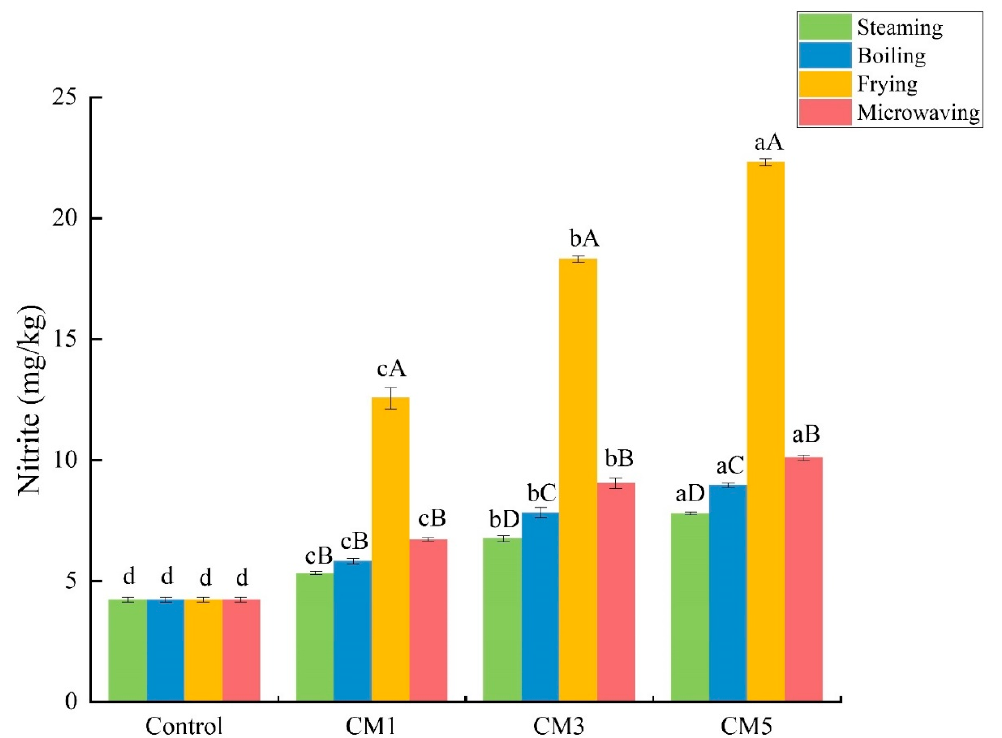
Figure 2. Comparison of nitrite residues in camel meat after different heat processing methods. Different lowercase letters indicate significant differences according to the different heating times ( p < 0.05), and different capital letters indicate significant differences according to the different heating treatments ( p < 0.05). The control group was untreated. The definitions of CM1, CM2, CM3, CM4, and CM5 are shown in Table 1.